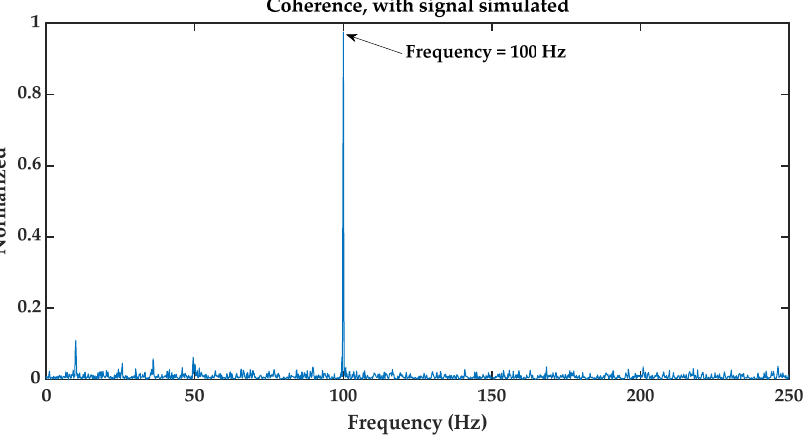
Figure 4. 𝒯 (cid:3032) cross-spectral density, with two synthetic signals: 𝑆 (cid:2869) = 𝑠𝑖𝑛(2𝜋10𝑡) + 𝑠𝑖𝑛(2𝜋100𝑡) and 𝑆 (cid:2869) = 𝑠𝑖𝑛(2𝜋50𝑡) + 𝑠𝑖𝑛(2𝜋100𝑡) . Figure 5. 𝒯 (cid:3032) cross-spectral density in Scale 2 , with two synthetic signals: 𝑆 (cid:2869) = 𝑠𝑖𝑛(2𝜋10𝑡) + 𝑠𝑖𝑛(2𝜋100𝑡) and 𝑆 (cid:2869) = 𝑠𝑖𝑛(2𝜋50𝑡) + 𝑠𝑖𝑛(2𝜋100𝑡) . Absolute error 1 ∗ 10 (cid:2879)(cid:2871) .